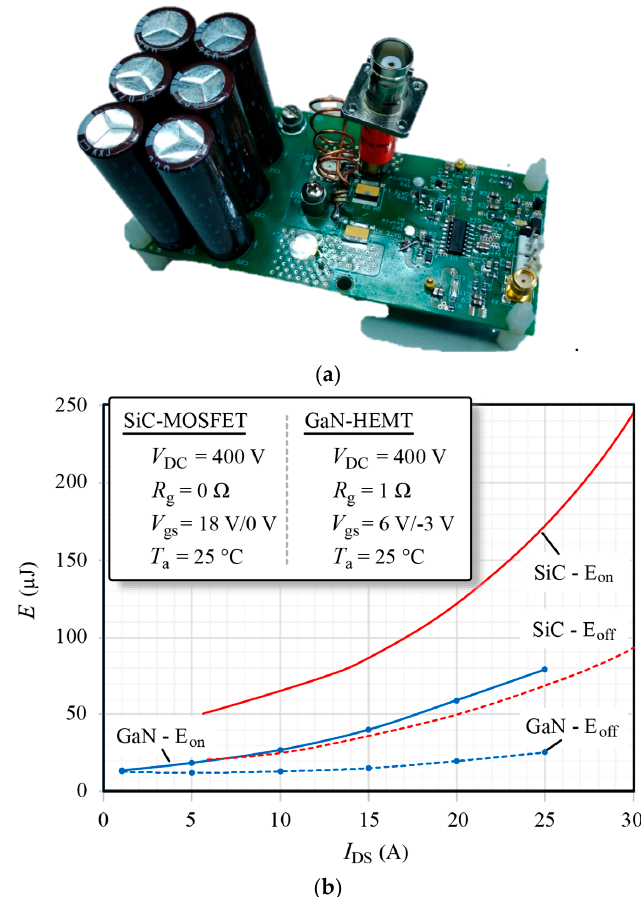
Figure 14. ( a ) Testbench for benchmarking and extraction of turn-on and turn-off switching losses of a 650 V/30 A GaN transistor; ( b ) switching loss comparison of 650 V/30 A SiC–MOSFET and GaN of a 650 V / 30 A GaN transistor; ( b ) switching loss comparison of 650 V / 30 A SiC–MOSFET and transistor. GaN